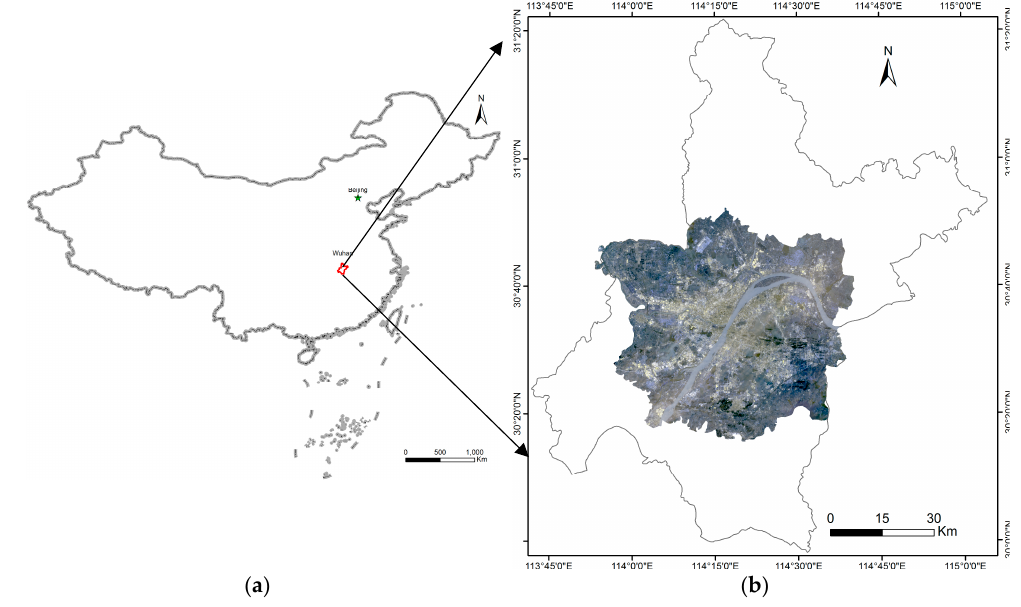
Figure 1. Location of study area (R: Band4, G: Band3, B: Band2 of Landsat 8 image).